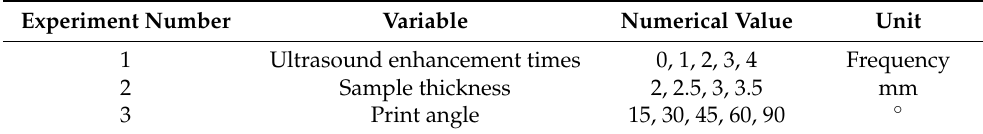
Table 2. Experimental